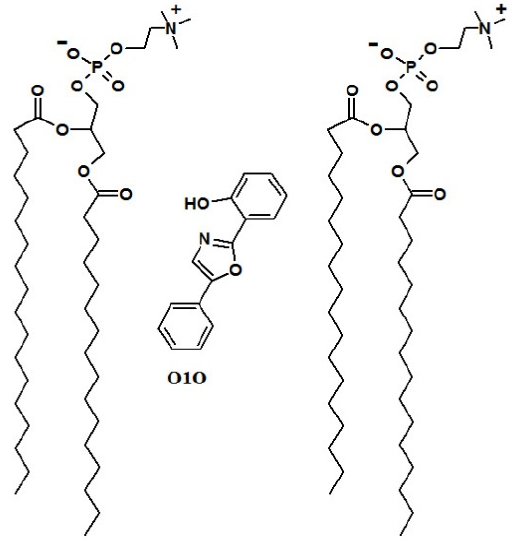
Figure 8. Localization and orientation of fluorescent probe O1O (2- (2 ′ - ОН -phenyl)-5-phenyl-1,3- oxazole) in phospholipid membranes. Two molecules of phosphatidylcholine from the outer leaflet are shown to denote the localization of the probe. (Adapted from Posokhov and Kyrychenko, 2018).